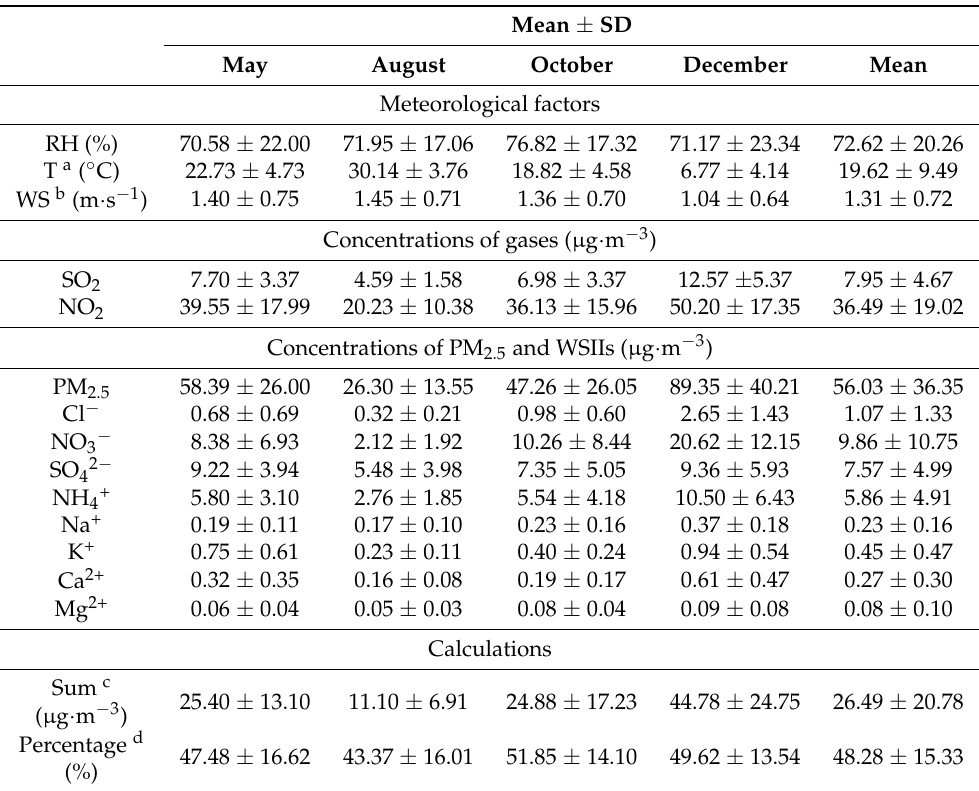
Table 2. The mean (mean ± standard deviation) of meteorological factors, concentrations of gases and